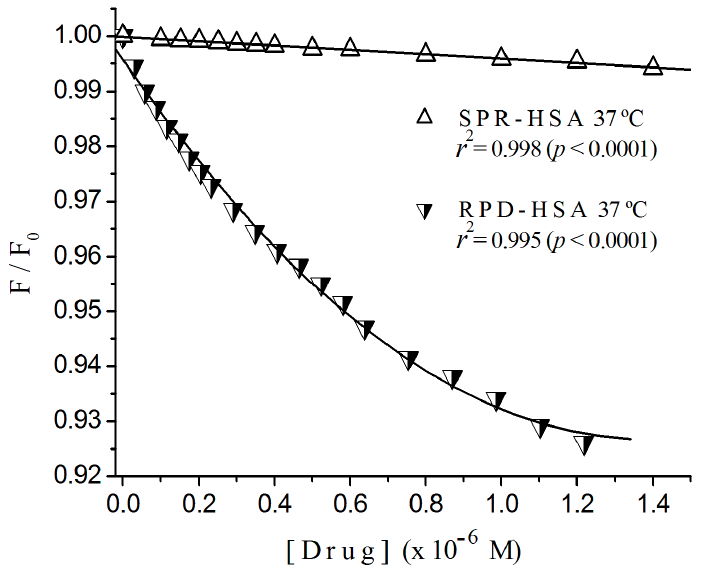
Figure 4. Normalized fluorescence quenching plots of HSA titrated with sulpiride and risperidone at